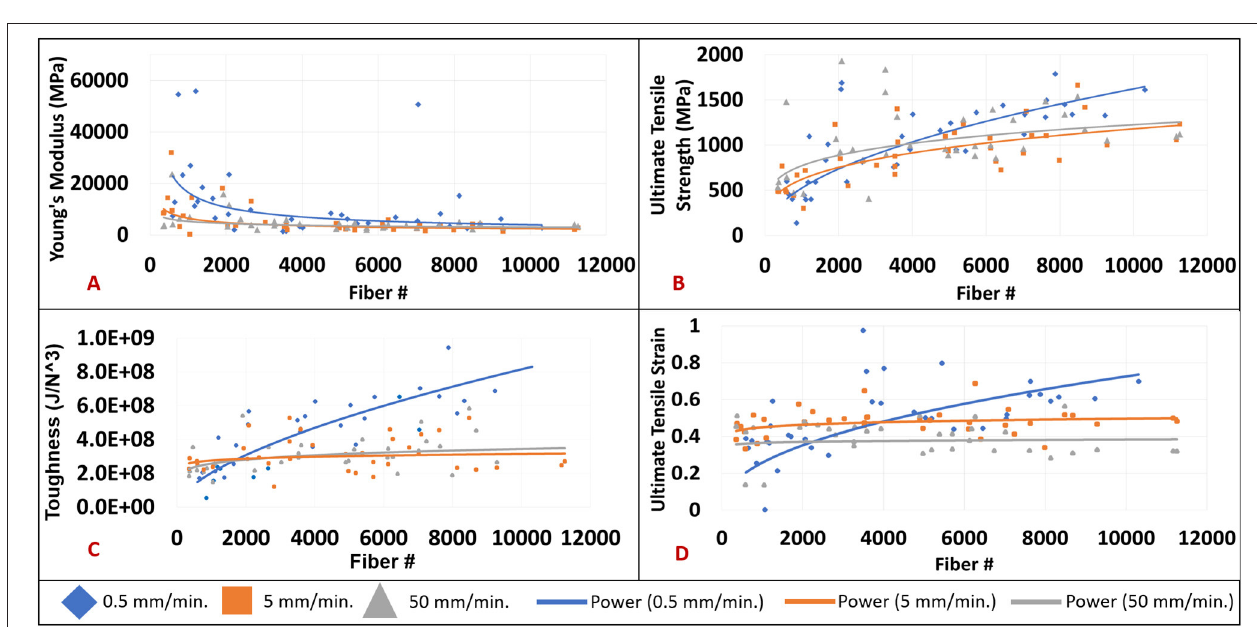
FIGURE 5 | (A) Young’s modulus (MPa) by fiber number at strain rates of 0.5 mm/min. (blue diamond), 5 mm/min. (orange square), and 50 mm/min. (gray triangle). (B) Ultimate tensile strength (MPa) by fiber number at strain rates of 0.5 mm/min. (blue diamond), 5 mm/min. (orange square), and 50 mm/min. (gray triangle). (C) Toughness (J/N 3 ) by fiber number at strain rates of 0.5 mm/min. (blue diamond), 5 mm/min. (orange square), and 50 mm/min. (gray triangle). (D) Ultimate tensile strain by fiber number at strain rates of 0.5 mm/min. (blue diamond), 5 mm/min. (orange square), and 50 mm/min. (gray triangle).